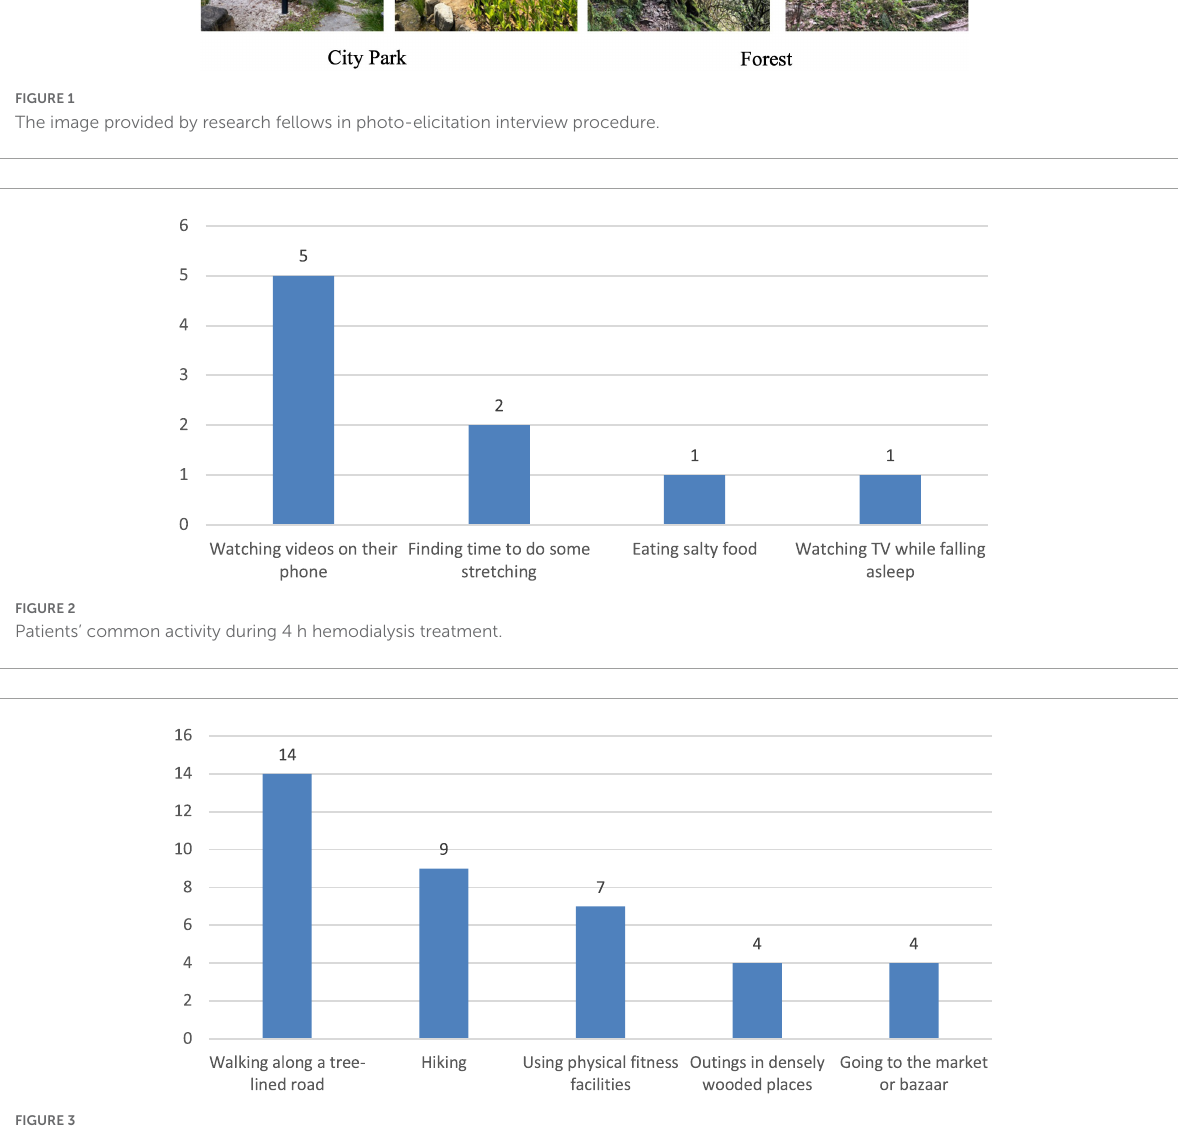
The participants continuously had their ECG measurements taken, watched the same 360-degree videos, and filled the questionnaire